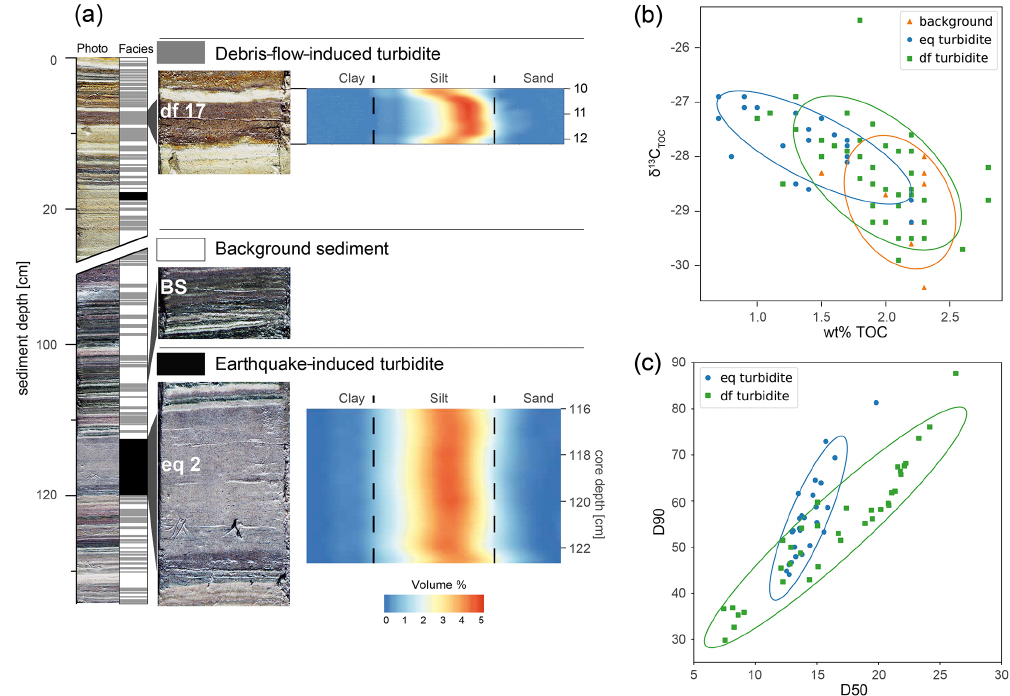
Figure 6. Event deposit characterization in sediment core Plan 19-02. (a) Core image of Plan 19-02 and corresponding core log shows finely laminated background sediment intercalated by debris-flow-induced turbidites (df turbidites) and earthquake-induced turbidites (eq turbidites). df turbidites have a gradual fining upward grain size trend, whereas eq turbidites are homogeneous deposits on top of a thin coarse base. eq turbidites show broader grain size distributions (poorer sorting). (b) The TOC /δ 13 C plot of samples from all cores shows general differences for df and eq turbidites and similarities between df turbidites and the (predominantly clastic) background sediment. (c) The D50/D90 grain size plot of df and eq turbidite samples from all cores highlights the different evolution of df and eq turbidites. Coloured ellipses represent the 95% confidence